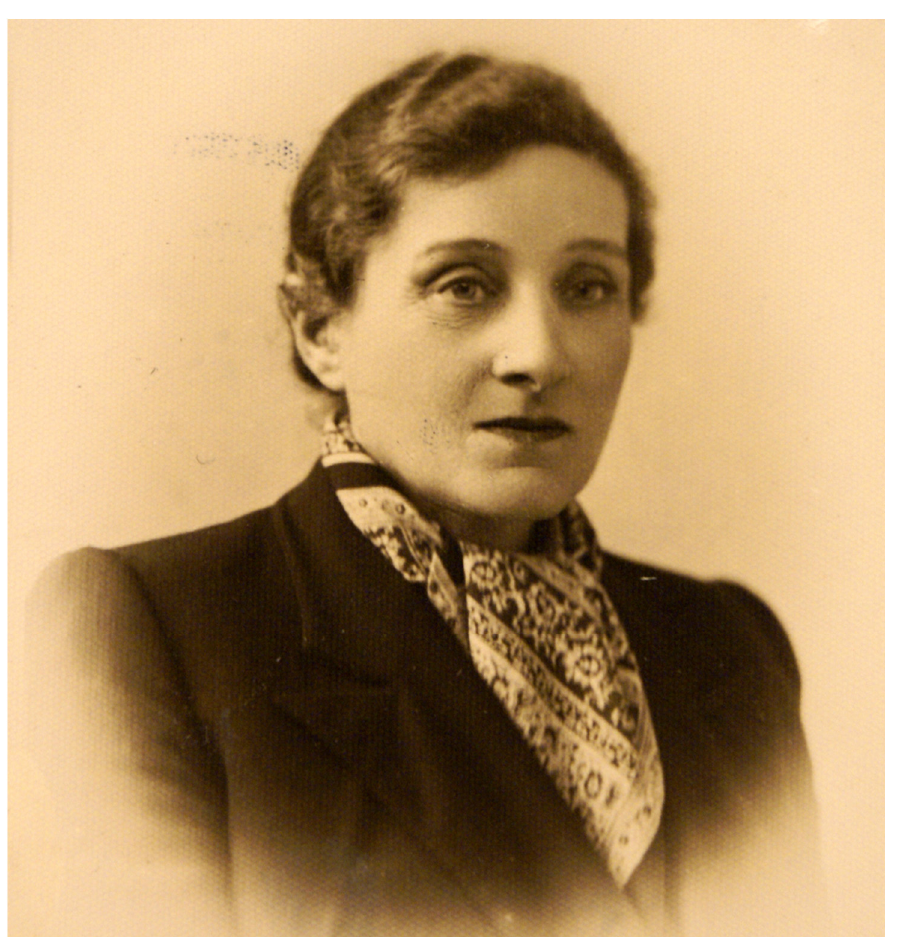
Figure 1. Bronis ł awa Brandla Fejgin (1883–1943). Source: Main Physicians Library, Warsaw, Po- Figure 1. Bronisława Brandla Fejgin (1883–1943). Source: Main Physicians Library, Warsaw, Poland land (public domain). (public